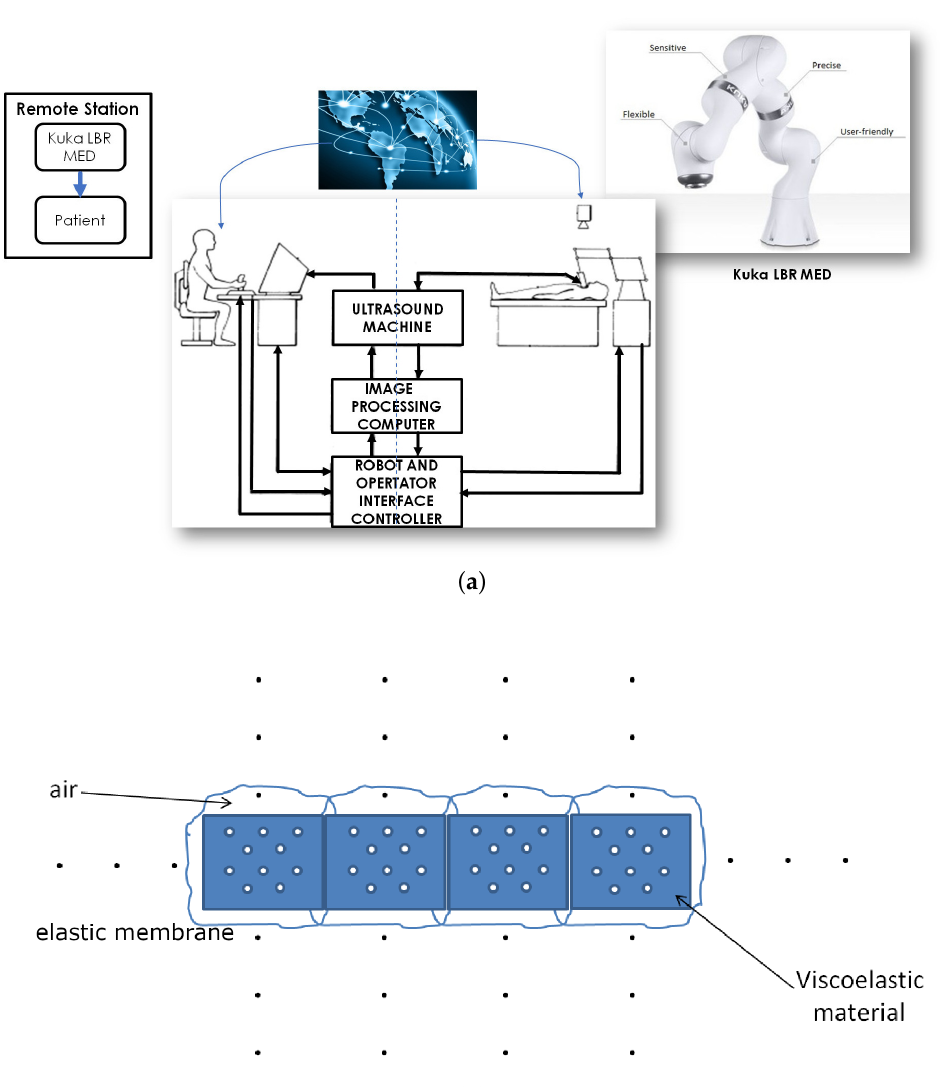
Figure 1. ( a ) Schematics of the proposed remote ultrasound scan setup. ( b ) Structure of he artificial